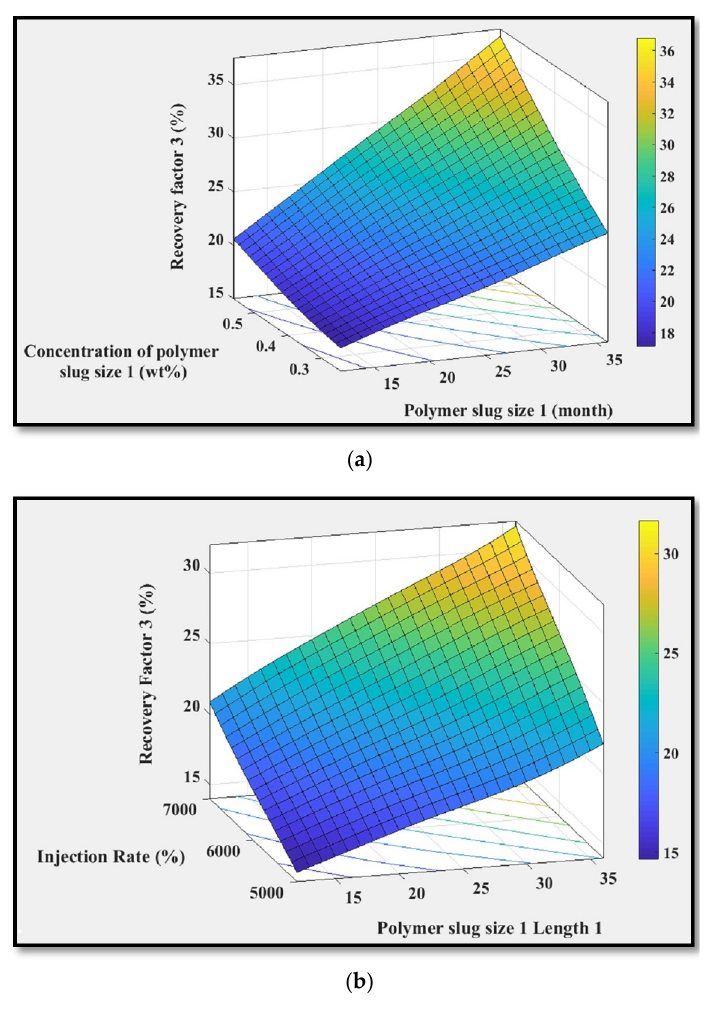
Figure 11. Description of the interactive effect of ( a ) polymer slug 1 size and the polymer slug 1 concentration on RF 3 and ( b ) polymer slug 1 size and the injection rate on RF 3 .